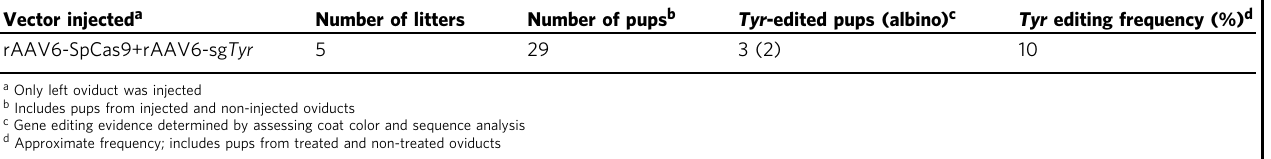
able to introduce a 771 bp BFP cassette into the Tyr locus with a frequency in embryos as high as 57%. Surprisingly, a lower per- centage of live-born animals carried such HDR events (1/20 and 2/24 for the point mutation and BFP insertion, respectively). One possible explanation is that these founder mice are mosaic and